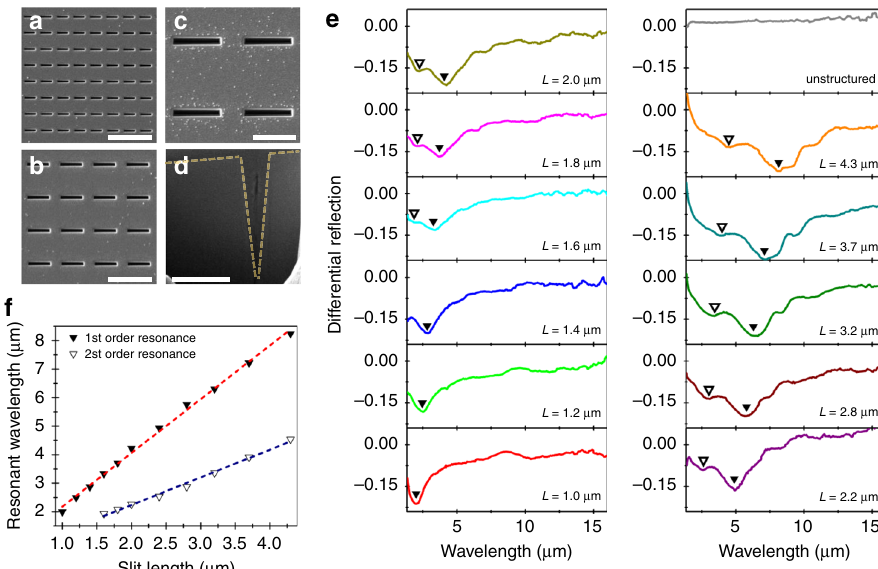
Fig. 3 Infrared resonances of nanoslit metamaterials. a – c SEM images of slit arrays with lengths L = 1.0, 2.0, and 4.3 μ m, respectively. Scale bar corresponds to 4 μ m. d Cross-sectional image of slit array of length 4.3 μ m. Scale bar corresponds to 2 μ m. Dashed light yellow lines are an aid to mark the v-shaped contour of the slit. e Experimental infrared differential re fl ection spectra from slit arrays of different slit lengths from 1.0 to 4.3 μ m. Pronounced resonances, both fi rst ( ▼ ) and second order ( ▽ ) are observed that red-shift with the slit length. f Resonant wavelength as a function of slit length for the fundamental and second order resonant modes in the nanoslit arrays.